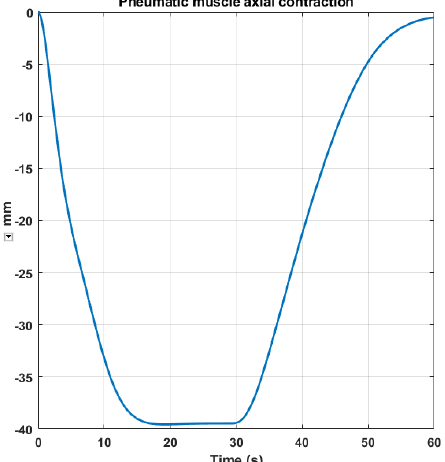
Figure 9. Variation versus time of the pneumatic muscle feed pressure.